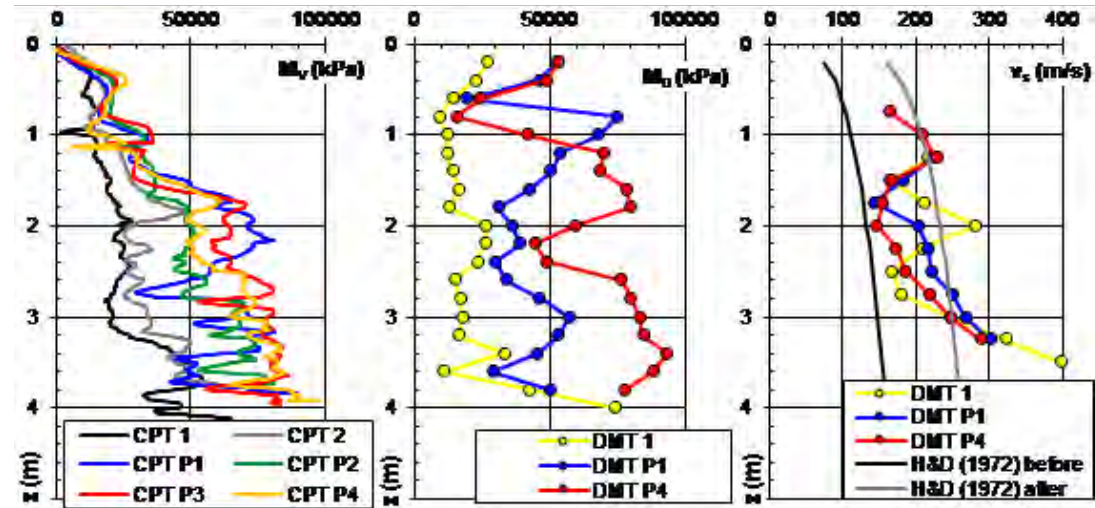
Figure 18. Constrained modulus (MV-CPT and MD-DMT)and measured/calculated v